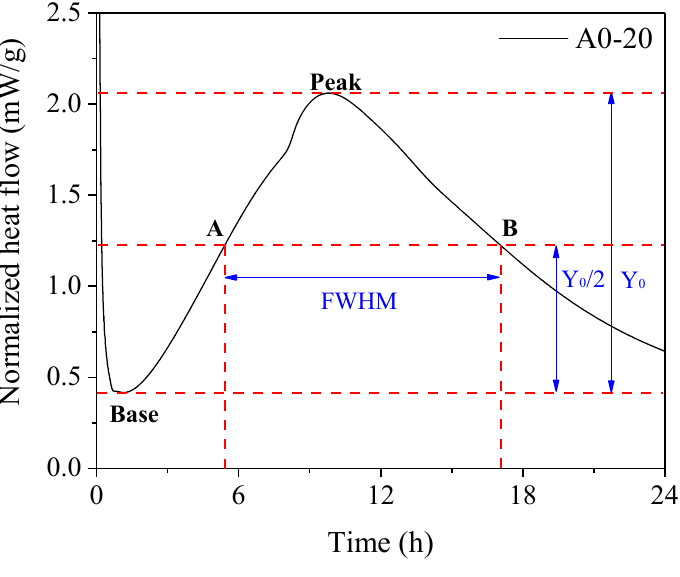
Figure 9. Calculation principle of FWHM value.